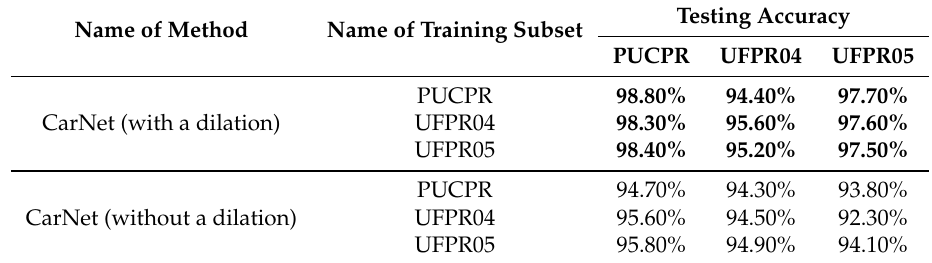
Table 4. Comparison of testing accuracies for Carnet (with a dilation) versus CarNet (without a dilation).